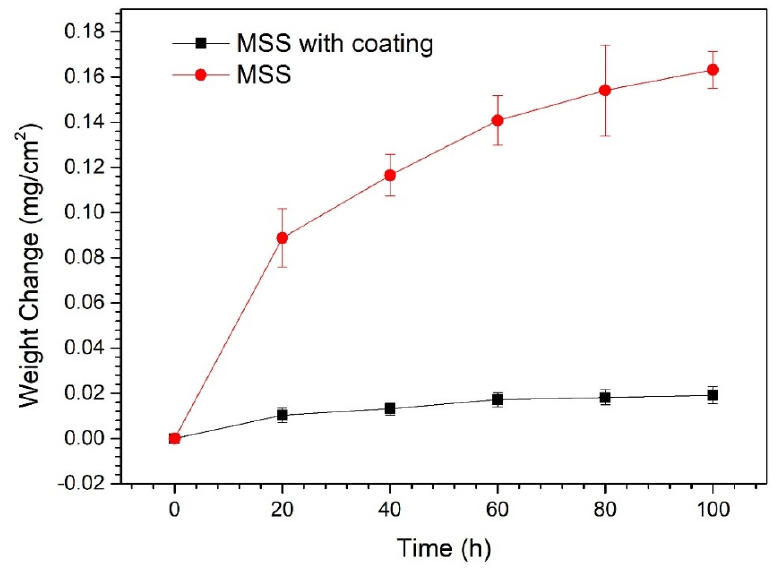
Figure 3. Interrupted oxidation kinetics of MSS with and without GCC at 650 °C.